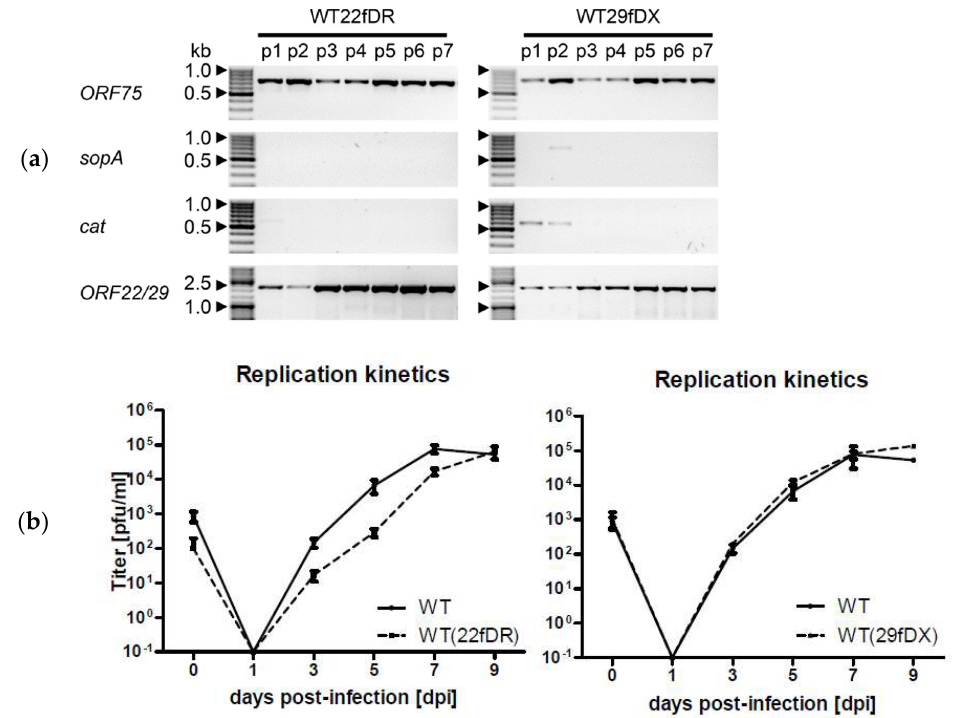
Figure 2. Genomic monitoring and replication properties of the self-repairing virus variants WT22fDR and WT29fDX. ( a ) PCR analysis of viral genomes during passaging of the virus variants in permissive OMK cells. ORF75 served as a viral control, sopA and cat were parameters for the respective part of the miniF that was to be lost, and ORF22/29 PCR indicated self-restoration of the ORF harboring the miniF sequence. Inverse gray shades are depicted. All band sizes were of the expected size. ( b ) Exemplary replication kinetics of one experiment of at least three separate experiments of the self-repaired virus variants after passage 9 (p9). The harvested supernatants were titrated in three individual dilution series of which mean and standard deviation are indicated. Virus titers are given in plaque-forming units (pfu)/mL in relation to the day they were harvested.